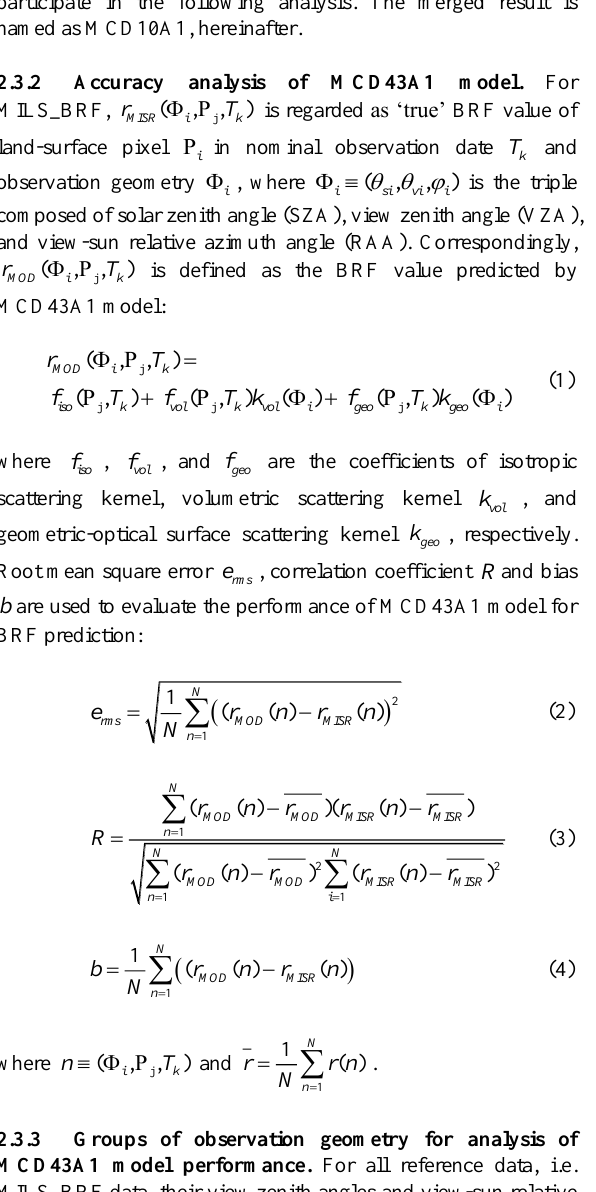
view-sun relative azimuths are divided into three groups: principal plane (PP) ± 30 ° (near PP directions, nPP), cross principal plane (CP) ± 30 ° (near CP directions, nCP) and other (XP) azimuths. Their specific angular ranges are (0 ° , 30 ° )